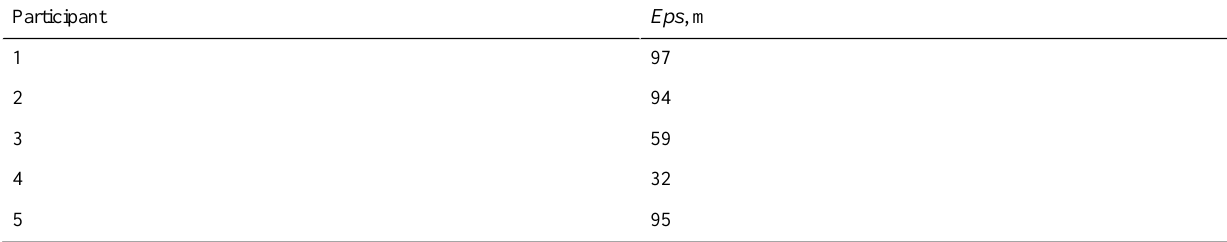
Table 1. Optimal cluster radius ( Eps ) value for each